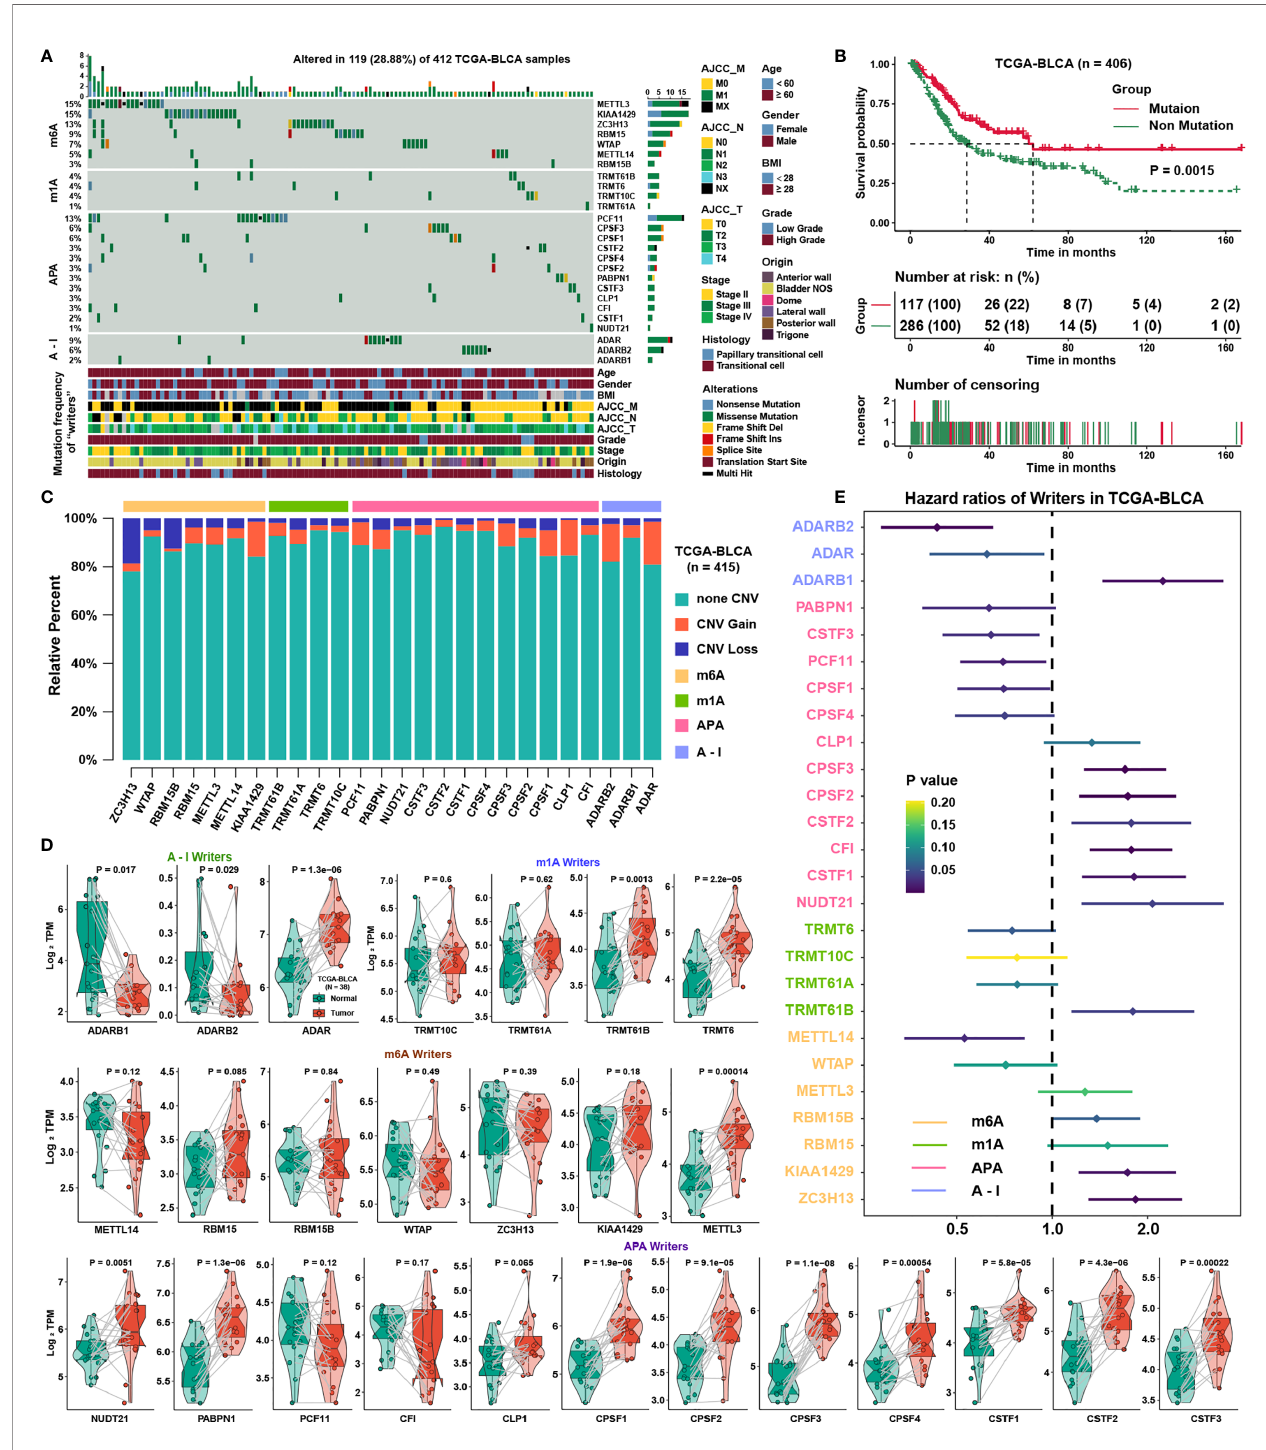
FIGURE 1 | Genetic and transcriptional alterations of RNA modi fi cation writer genes in BLCA. (A) The mutation frequency of 26 RNA modi fi cation writers in 412 BLCA patients from the TCGA cohort. (B) Kaplan-Meier curves showing the overall survival of patients with or without mutations in RNA modi fi cation writer genes in the BLCA cohort. p < 0.05 in the two-sided log-rank test was considered statistically signi fi cant. (C) Bar graphs showing the frequency of CNV gain, loss and non_CNV of RNA modi fi cation writer genes in the TCGA-BLCA cohort. The height of each bar represents the alteration frequency. (D) Box plots show the expression distribution of 26 writer genes of 4 types of RNA modi fi cations between paired normal and BLCA tissues. (E) The prognostic analyses for 26 writer genes in TCGA; a hazard ratio >1 represents a risk factor and a hazard ratio <1 represents a protective factor for